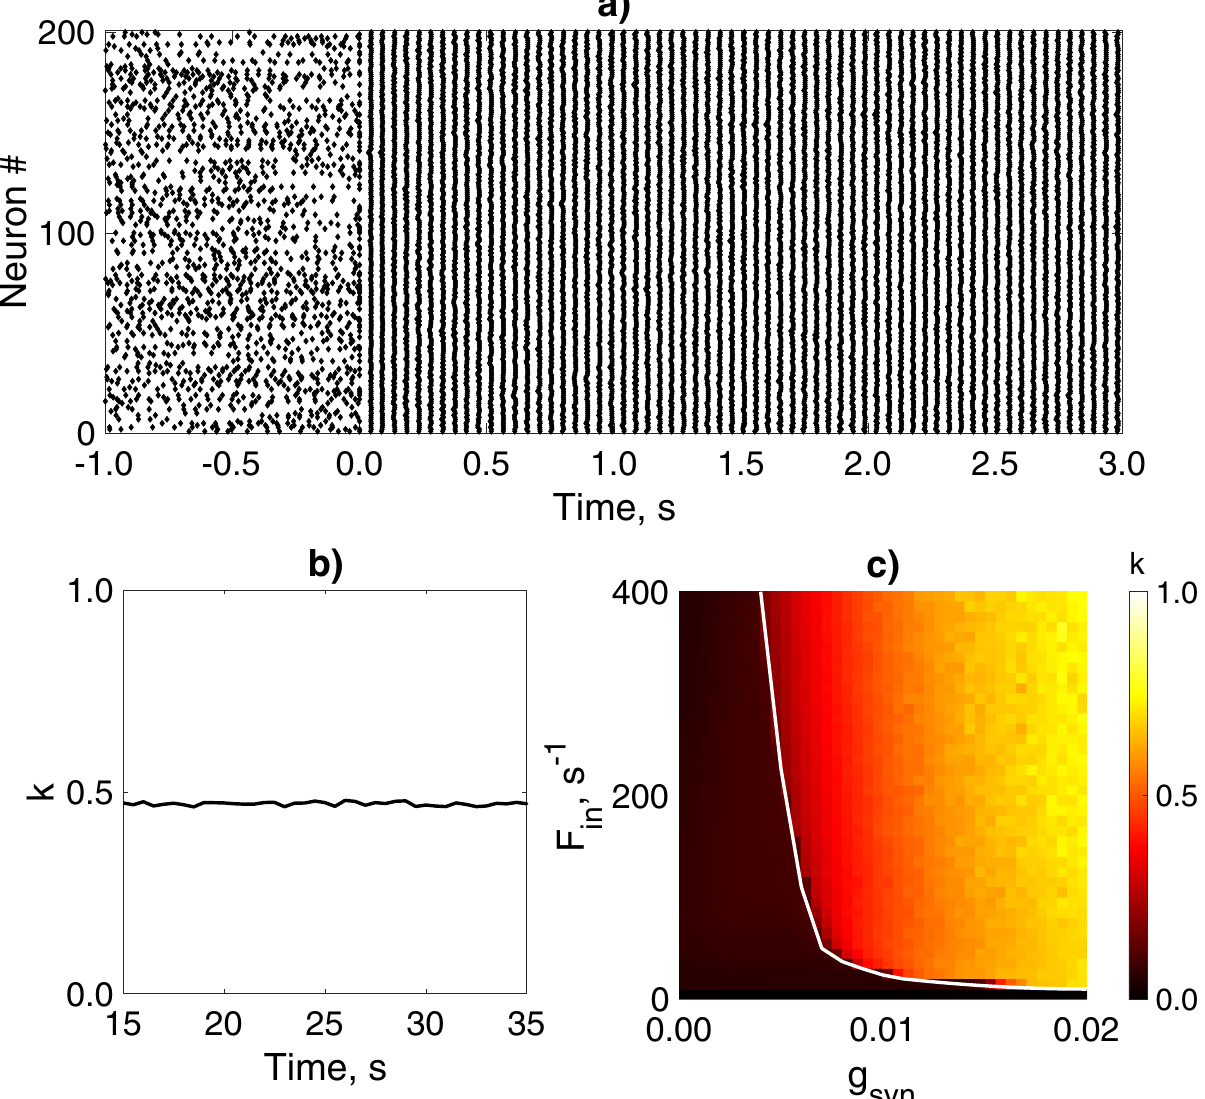
Figure 2. γ oscillations in the interneuron network model. ( a ) Raster plots of the interneuron network activity with default parameter settings. Synapses were activated at 0 s ( g syn = 0.01 mS/cm 2 , F in = 260 s − 1 ). ( b ) Coherence ( k ) is determined in 500-ms windows for the network oscillations shown on ( a ). ( c ) Mean network coherence ( k ) is plotted against the frequency of excitatory inputs ( F in ) and the synaptic weight between interneurons ( g syn ). The white line corresponds to the border of the synchronization region with k = 0.4 . Each pixel represents an average of over 10